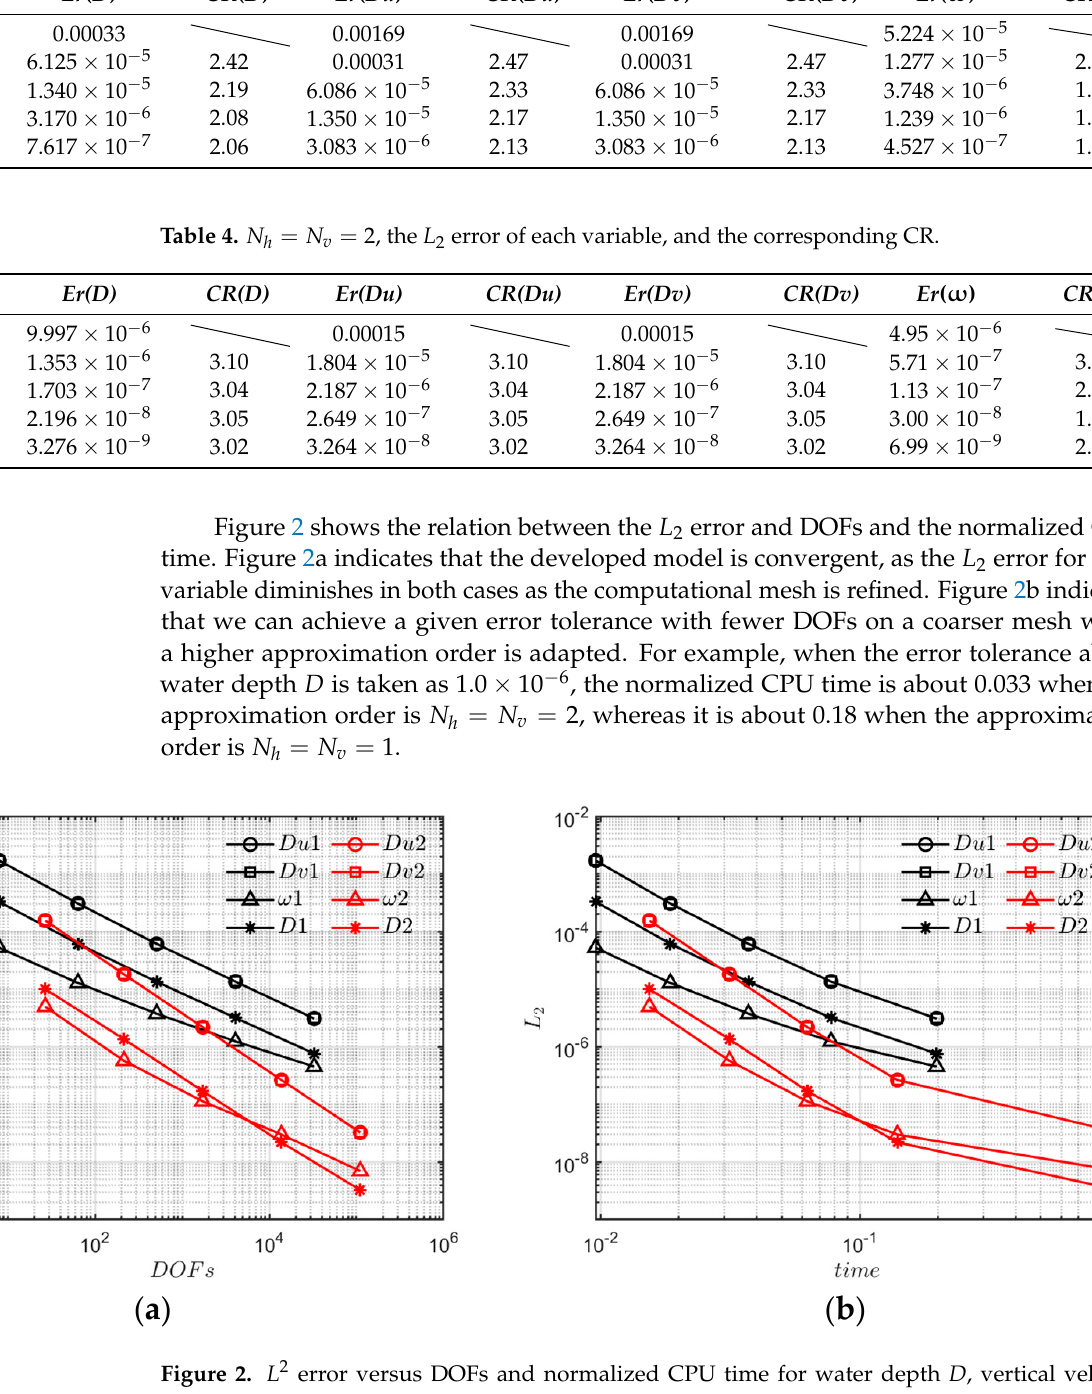
= 𝑁 = 1 (black), 𝑁 = h = N v = 1(black), ℎ 𝑣 ℎ